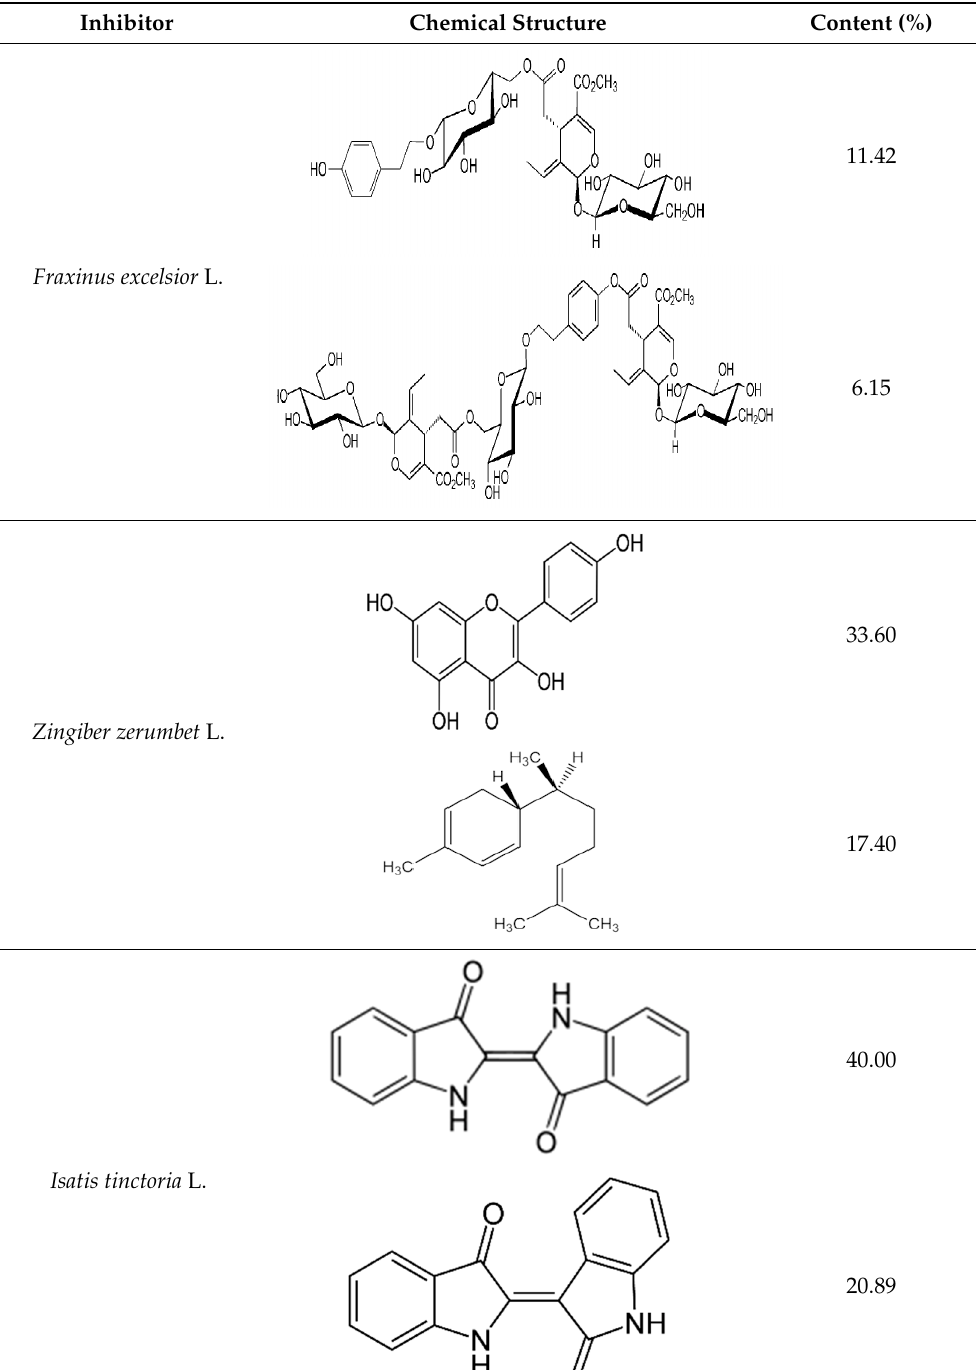
Table 1. Chemical structure of the major constituents found in the studied plant extracts [21–23,27]. Inhibitor